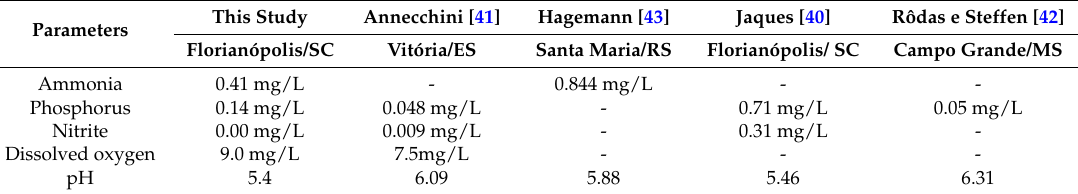
Table 5. Comparison of rainwater quality obtained in this study with results for other cities in Brazil.